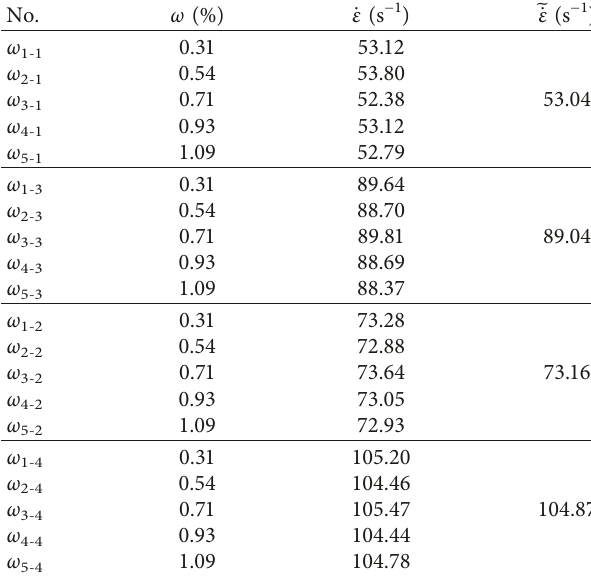
Table 1: Loading strain rates of specimens with different